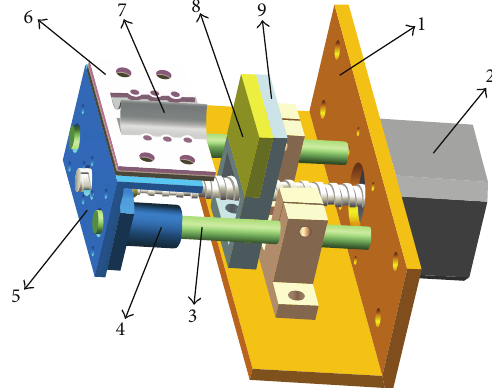
Figure 8: Structure of cutting mechanism. 1: mounting base, 2: screw motor, 3: bare guiding shaft, 4: linear bearing, 5: cutting blade mounting base, 6: cutting blade mounting board, 7: cutting blade, 8: rubber pad, and 9: rubber pad back